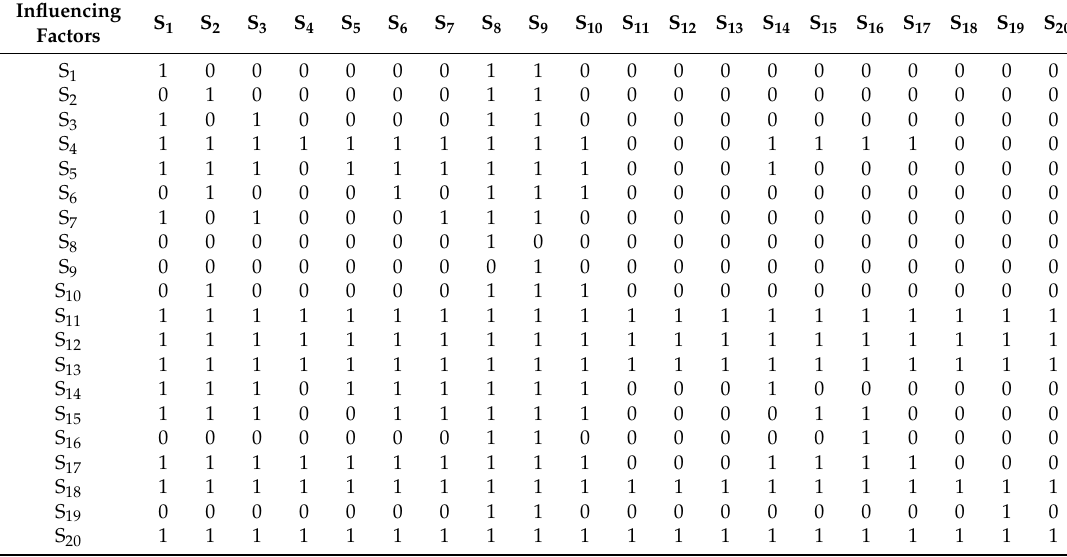
Table 5. Reachability matrix R.